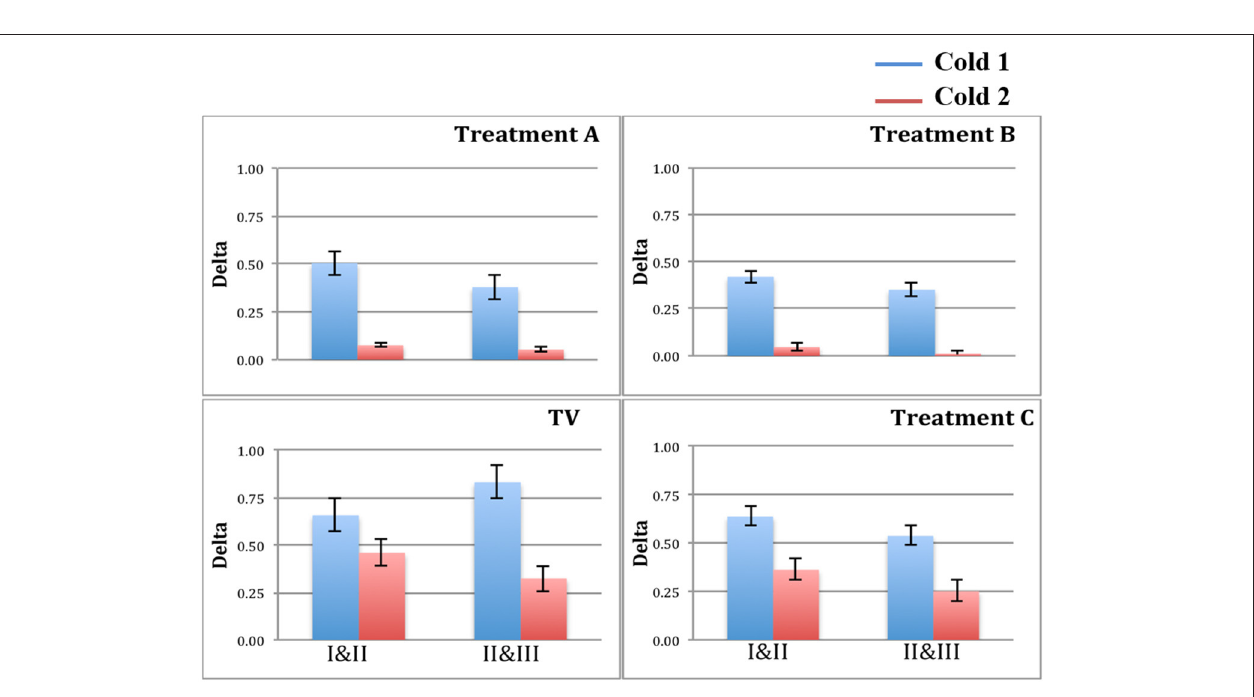
confirm that the new measure shows these statistically significant reductions for Cold2. We see the significant effect of comparing